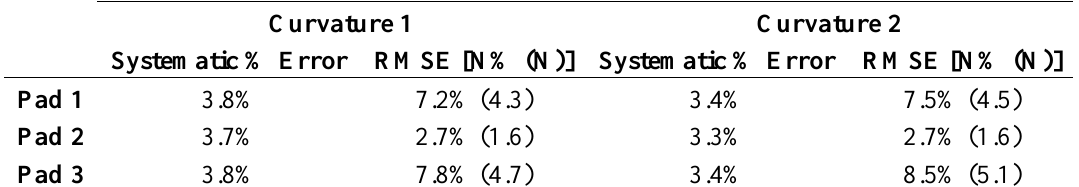
Table 2. Normalized and absolute RMSE of the estimated force, and systematic measurement error compared with the load-cell force, for the three pads under the three loading